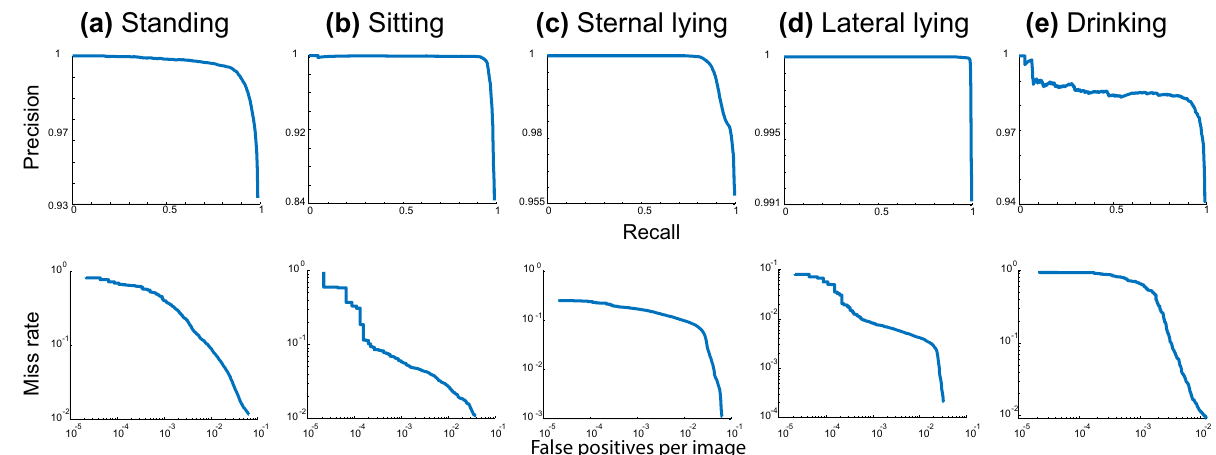
Figure 4. The performance of our primary model. Upper row: precision-recall curve. A point on the precision- recall curve is determined by considering all pig behaviours detected with a given threshold as positive predictions, then calculating the resulting precision and recall for that threshold. Below row: miss rate against FPPI. This characteristic curve obtained with similar mechanisms of the PR curve however to represent miss detected pigs; both axes are logarithmically we plotted the miss-rate changes against the number of false-positives per image ( FPPI ) by varying the threshold on the detection confidence, see (Fig. 4; second row) and (Supplementary Figure S1; second column). The curve shows that all classes (e.g., lateral lying) generated low miss rates at lower values FPPI , e.g., 10 − 2 .